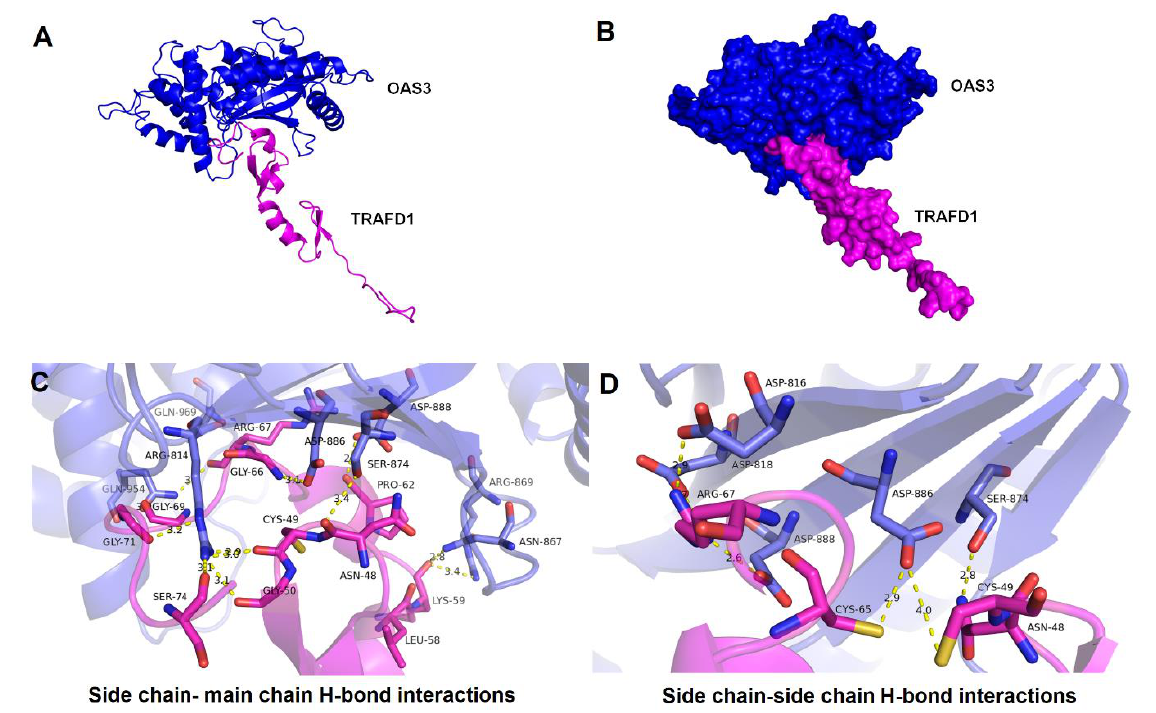
Figure 6. Docked mode of OAS3_D3-TRAFD1 complex and its structural mapping of intramolecular interfaces. ( A ) Cartoon representation of OAS3_D3-TRAFD1 docked complex having low energy score determined by HADDOCK docking. OAS3_D3 is displayed in blue color, and TRAFD1 is represented in magenta color. ( B ) A surface representation of OAS3_D3-TRAFD1 complex. ( C ) Interacting residues between OAS3_D3 and TRAFD1 obtained through hydrogen bonding between the side chain of OAS3_D3 and the main chain of TRAFD1 are shown in licorice representation, OAS3_D3 residues (blue) and TRAFD1 residues (in magenta). ( D ) Interacting residues between OAS3_D3 and TRAFD1 obtained through hydrogen bonding between the side chain of OAS3_D3 and the side chain of TRAFD1 are shown in licorice representation, OAS3_D3 residues (blue) and TRAFD1 residues (in magenta). The atomic distances are shown in yellow dotted lines in angstrom (Å ).